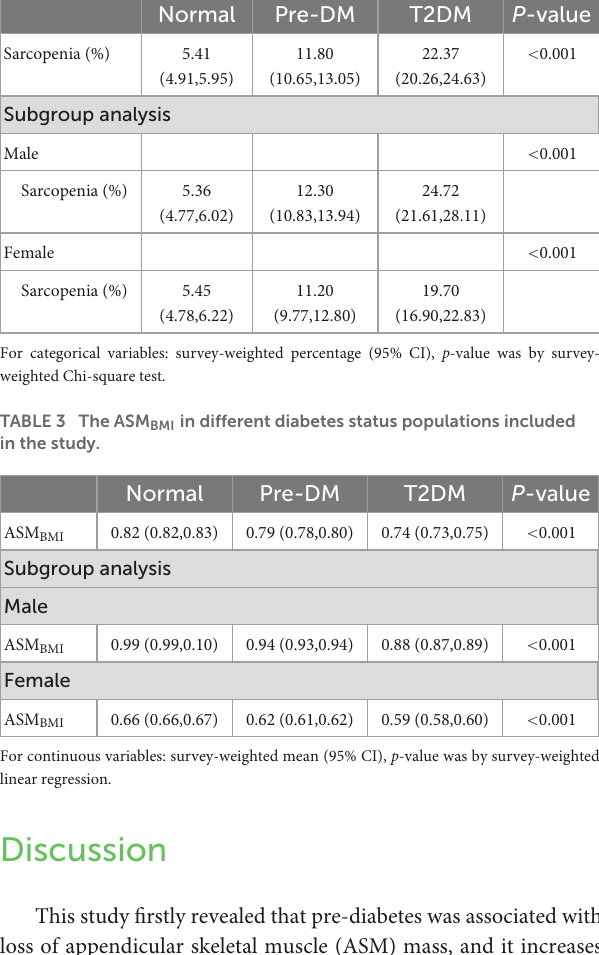
TABLE 2 The prevalence of sarcopenia in different diabetes status populations included in the study. Normal Pre-DM T2DM P -value Sarcopenia (%) 5.41 (4.91,5.95)